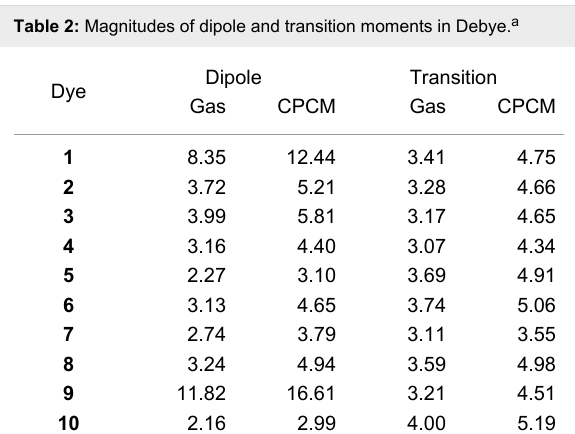
Table 2: Magnitudes of dipole and transition moments in Debye. a Dipole Dye